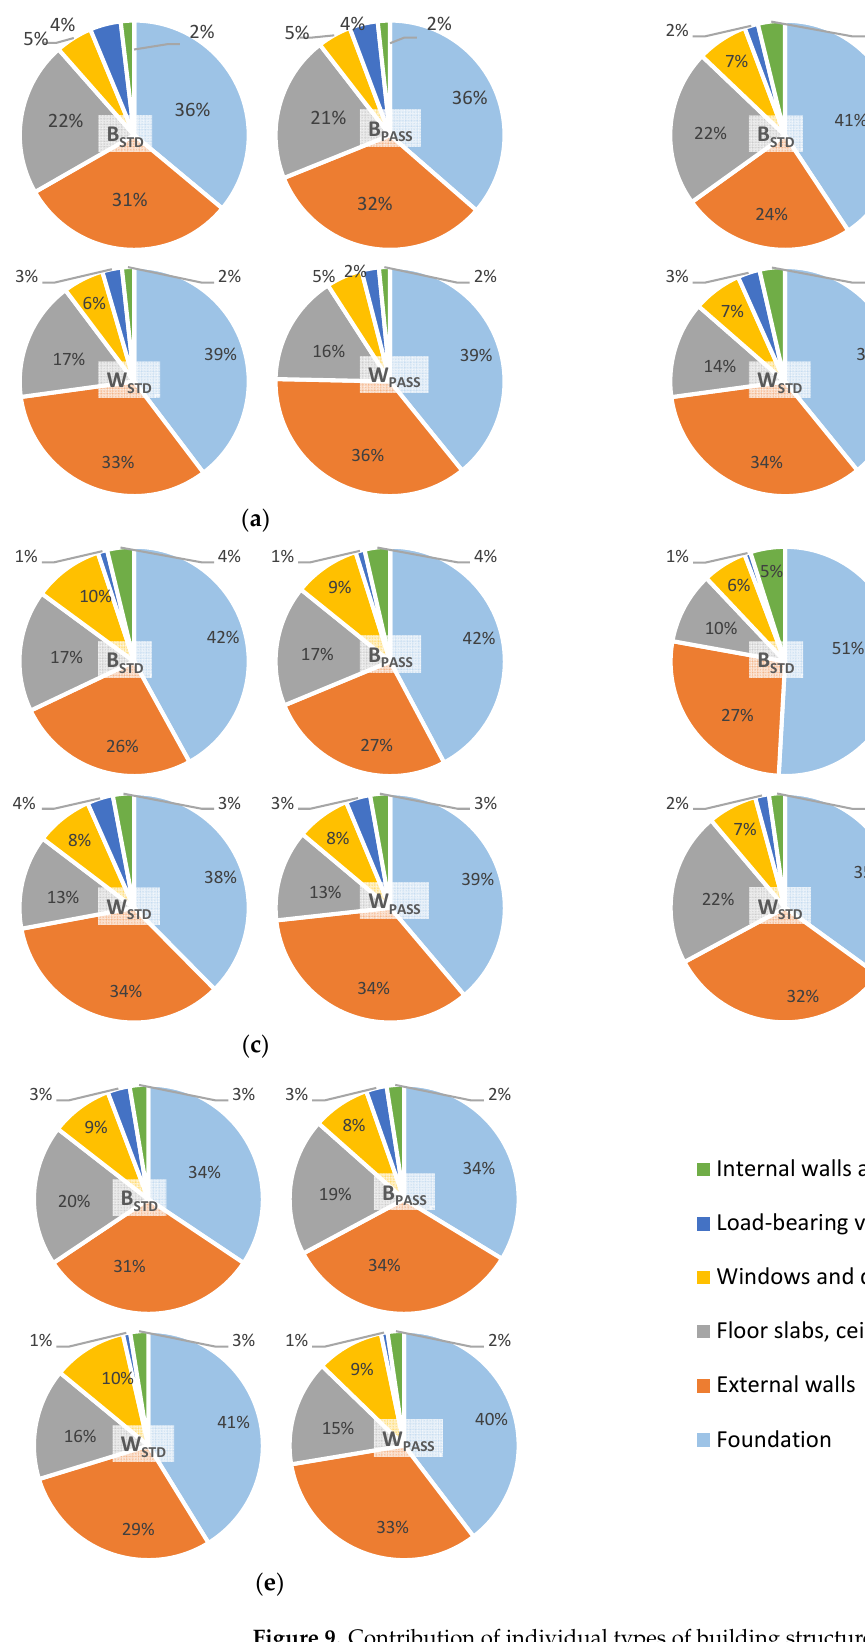
Figure 9. Contribution of individual types of building structures to environmental impact categories: global warming potential ( a ), acidification ( b ), eutrophication ( c ), ozone depletion potential ( d ), total use of primary energy ( e ), and legend ( f ).